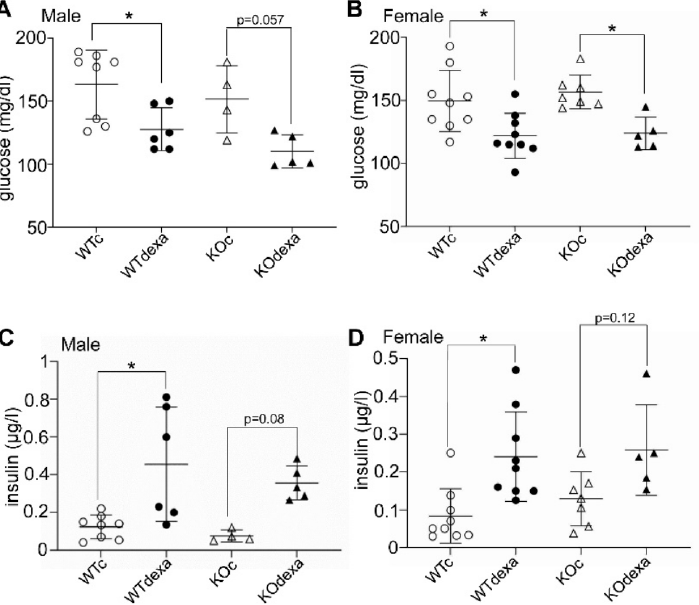
Figure 3. Serum levels of glucose in male ( A ) and female ( B ) mice, and insulin in male ( C ) and female ( D ) WT or Nrf2 KO mice after 13 weeks of treatment with vehicle or dexamethasone. Blood was drawn after 4 h of fasting. * p < 0.05 of the indicated comparison. WTc: wild-type control (vehicle-treated); KOc: Nrf2 knockout control (vehicle-treated); WTdexa: wild-type dexamethasone-treated; KOdexa: Nrf2 knockout dexamethasone-treated.